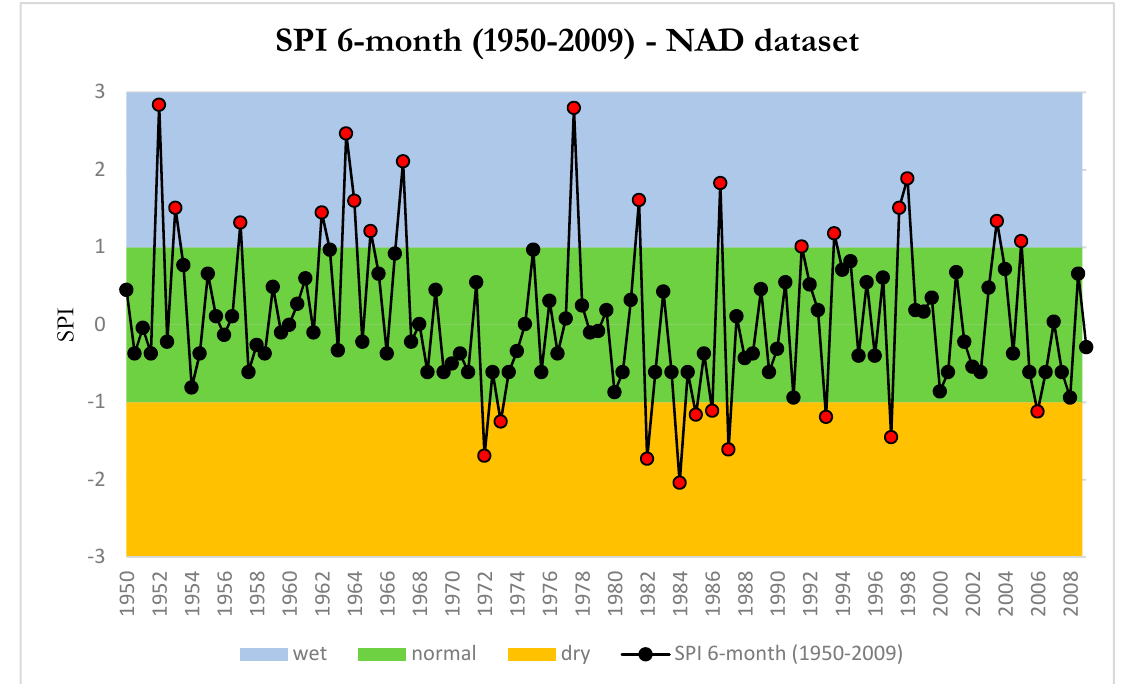
Figure 5. SPI 6-month (1950–2009) with wet, normal and dry bands—NAD dataset (red circles identify the years when SPI deviate from the normal range).